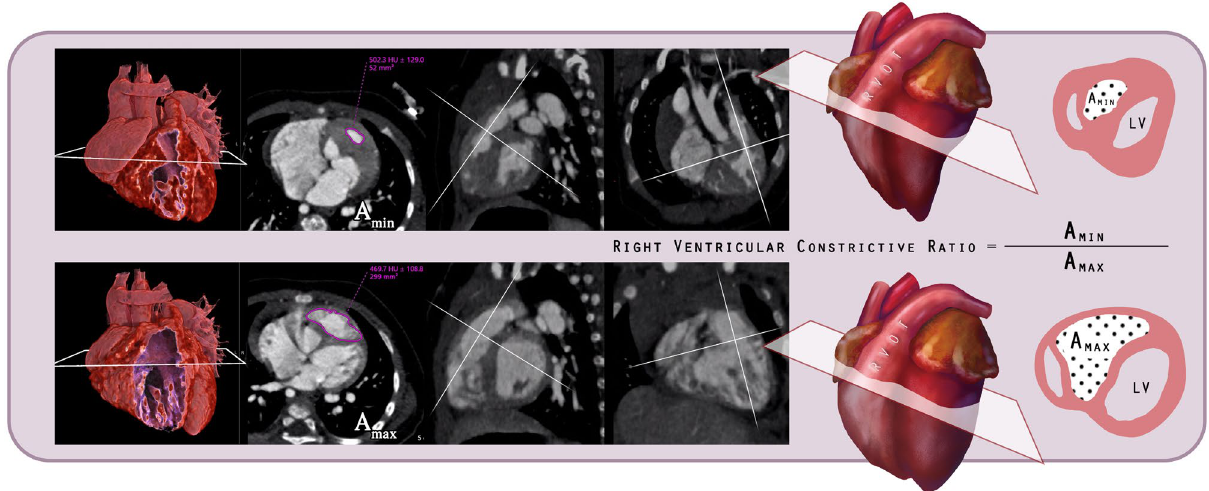
Figure 1. The patient was diagnosed with simple VSD and DCRV via CT. Surgeons performed a patch repair for VSD and resection of the hypertrophied muscular bundle. Three-dimensional myocardial model images of his heart during the end-systole (upper row) and end-diastole (lower row) are shown. The reformatted CT images from left to right are oblique axial, oblique sagittal, and oblique coronal sections in both upper and lower rows. Measured luminal areas A min and A max are outlined (in pink) on the cross-sectional images paralleled to the apparent muscular ridge. Right ventricular constrictive ratio (A min /A max ) for this patient was 17.4%. [ CT computed tomography; DCRV double-chambered right ventricle; VSD ventricular septal defect].